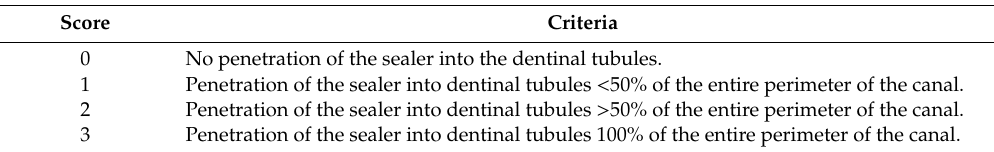
Table 2. Sealer penetration—Scoring